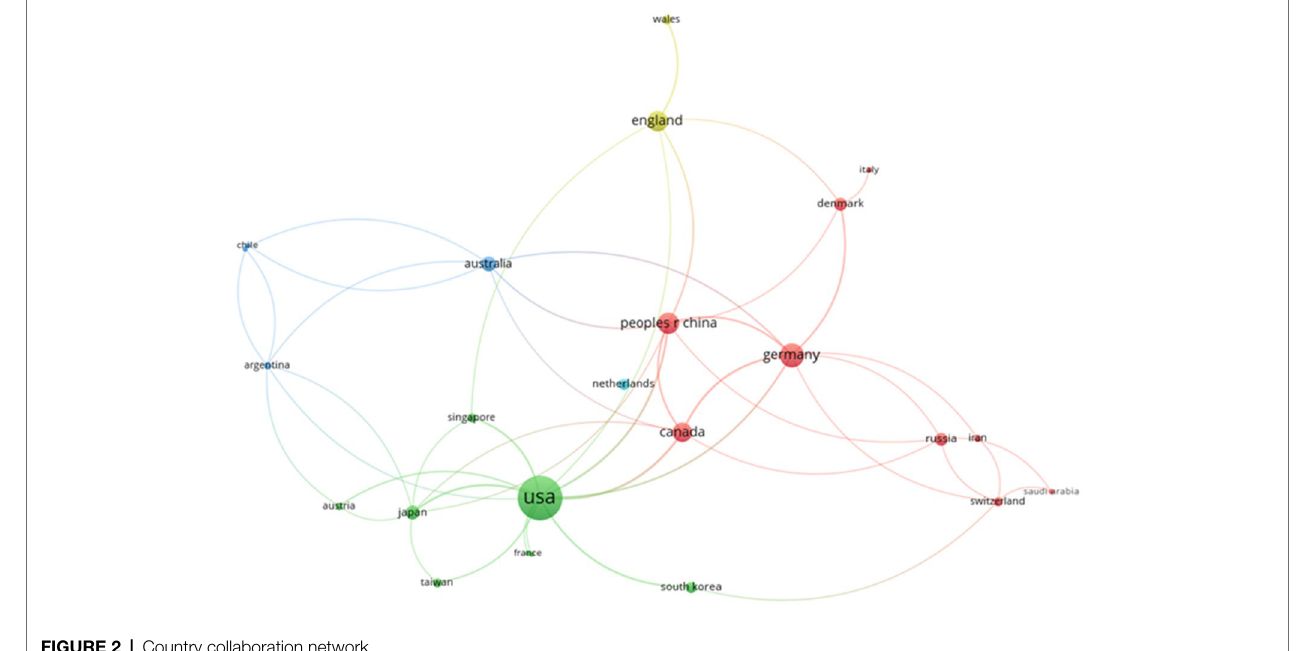
FIGURE 2 | Country collaboration network.